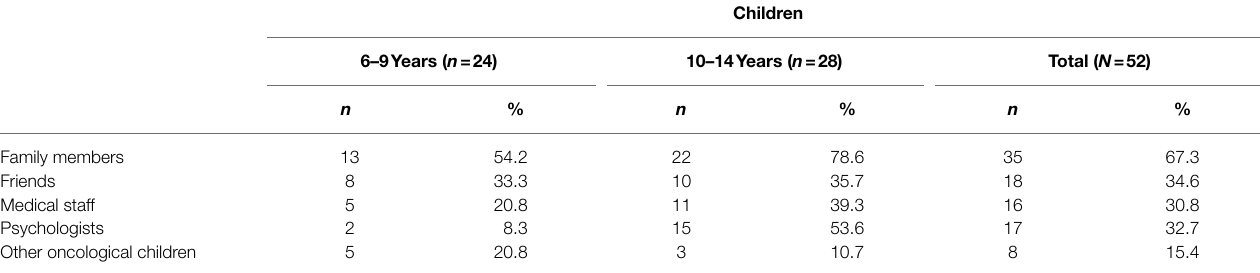
TABLE 7 | People to whom children prefer to communicate their emotional